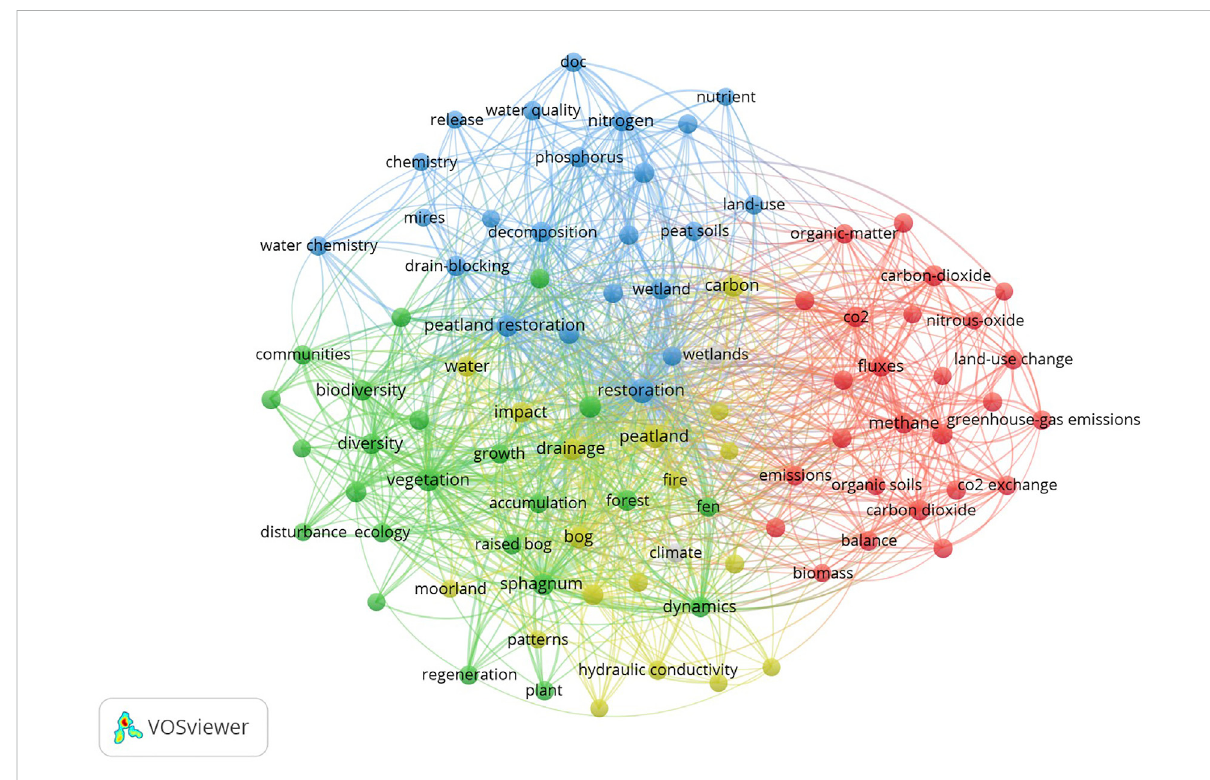
FIGURE 3 Main areas of RDP (co-occurrence network of